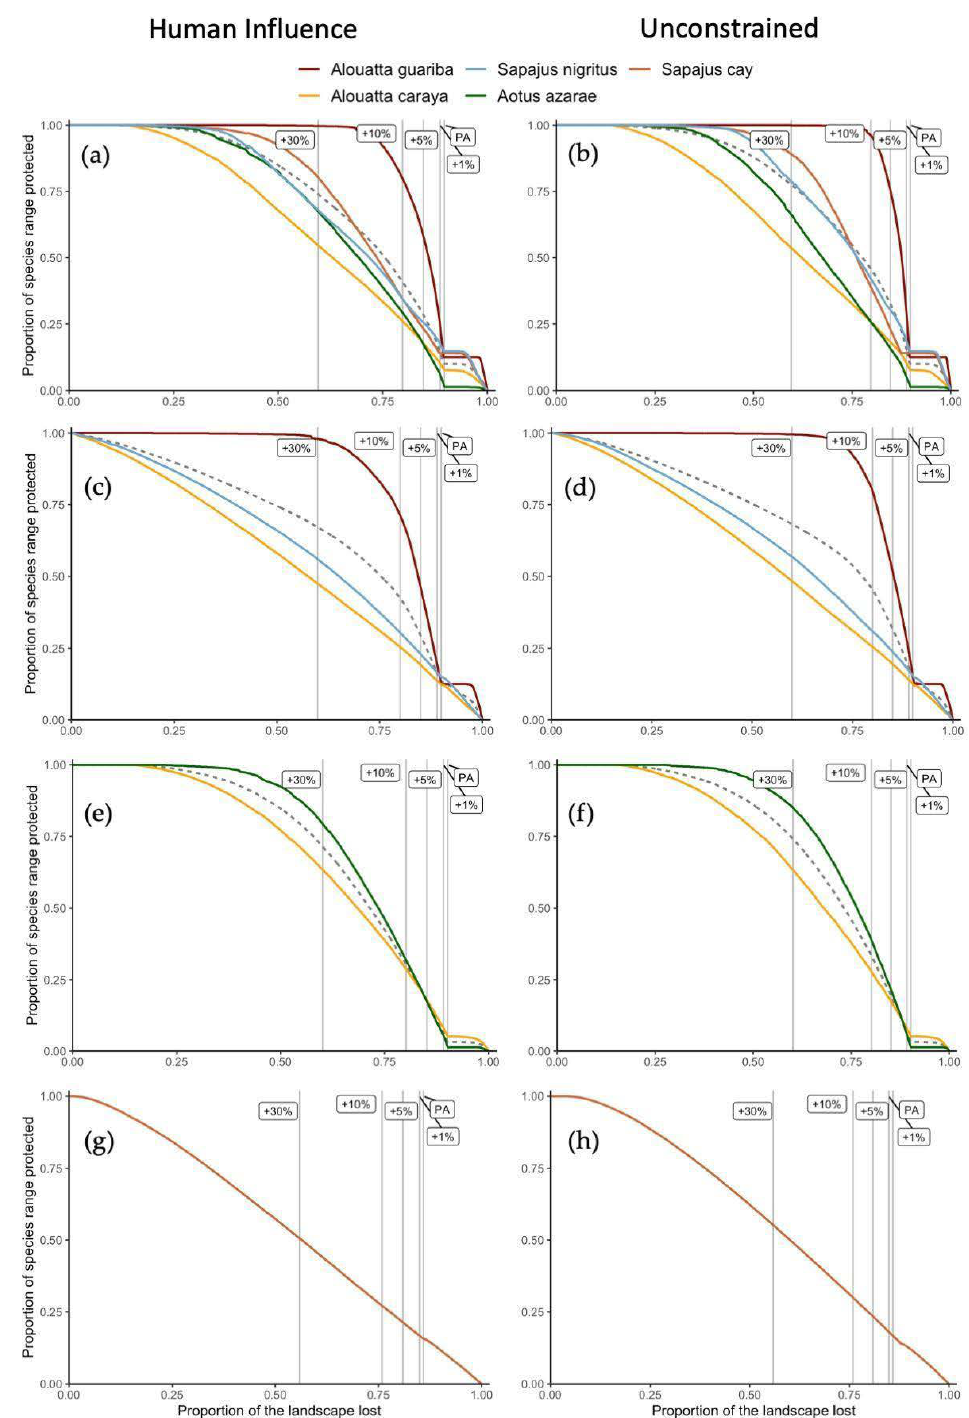
Figure 3. Performance curves are shown for prioritization at ( a , b ) national and ecoregional scale. i.e., Atlantic forest ( c , d ), Chaco ( e , f ), and Yungas ( g , h ). These curves represent the relationship between the proportion of the species’ distributional range protected ( y -axis, 1.00 = all range protected) and the proportion of the landscape lost for primate species ( x -axis, 1.00 = all landscape lost) under the human-influence scenario (i.e., with a human footprint as a cost) (left graphs) and for the unconstrained scenario (i.e., without a human footprint) (right graphs). Gray vertical lines indicate the 1%, 5%, 10%, and 30% of priority areas most important for primate conservation in Argentina.